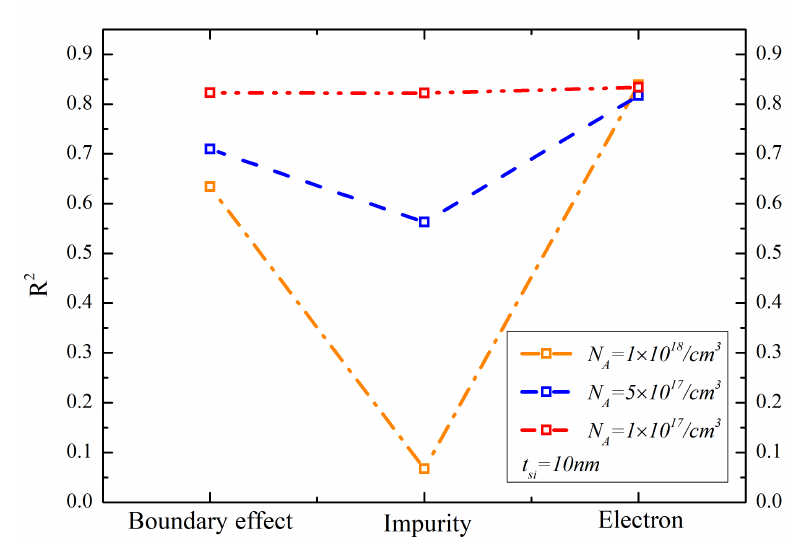
Figure 9. The reliability of the model influenced by the boundary, impurity-phonon and electron-phonon scattering mechanisms in the 10-nm silicon